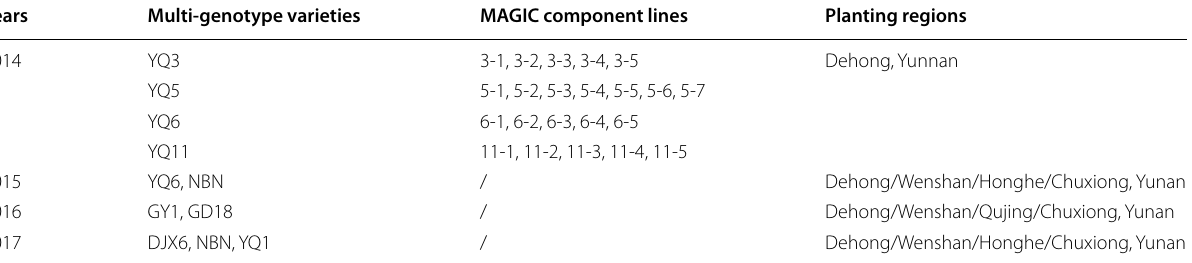
Table 1 Multi‑genotype varieties and planting regions for field experiments in different years Years Multi‑genotype varieties MAGIC component lines Planting